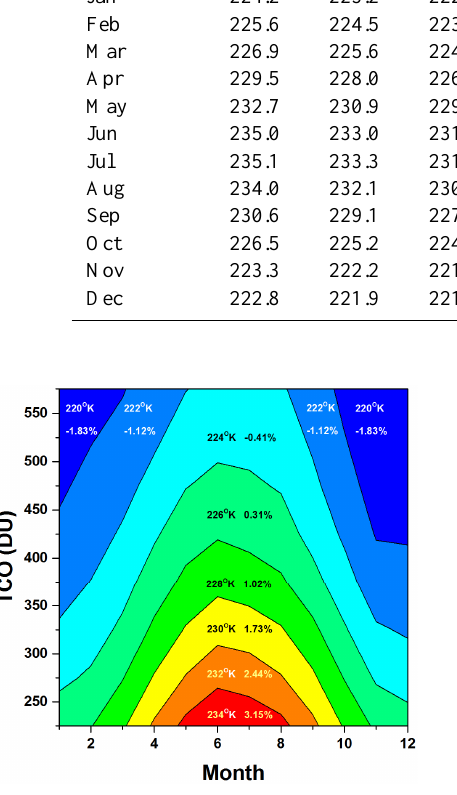
Figure 2. Ozone effective weighted temperatures T (OK) and the percent Pandora ozone correction function C(T ) (in %) based on a fixed retrieval temperature of 225OK for the latitude of Boul- der, Colorado, at 40 ◦ N as a function of total column ozone (TCO) amount and month. C Pandora = 0 . 00333 (T − 225 ) , where TCO- corr = TCO (1 + C(T ) ). The number pairs (T,C(T )) represent the average values temperature and percent correction for the colored area, not the contour